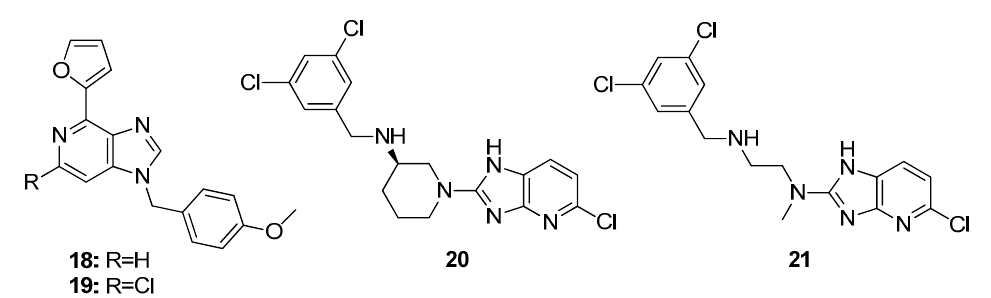
Figure 7. Antimicrobial imidazo[4,5- b ]pyridines and imidazo[4,5- c ]pyridines.